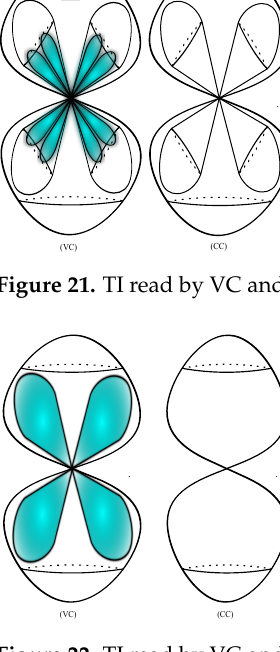
Figure 22. TI read by VC and CC at